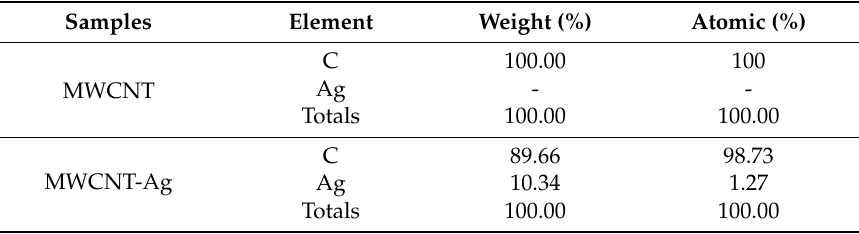
Table 3. Elemental composition of MWCMT and